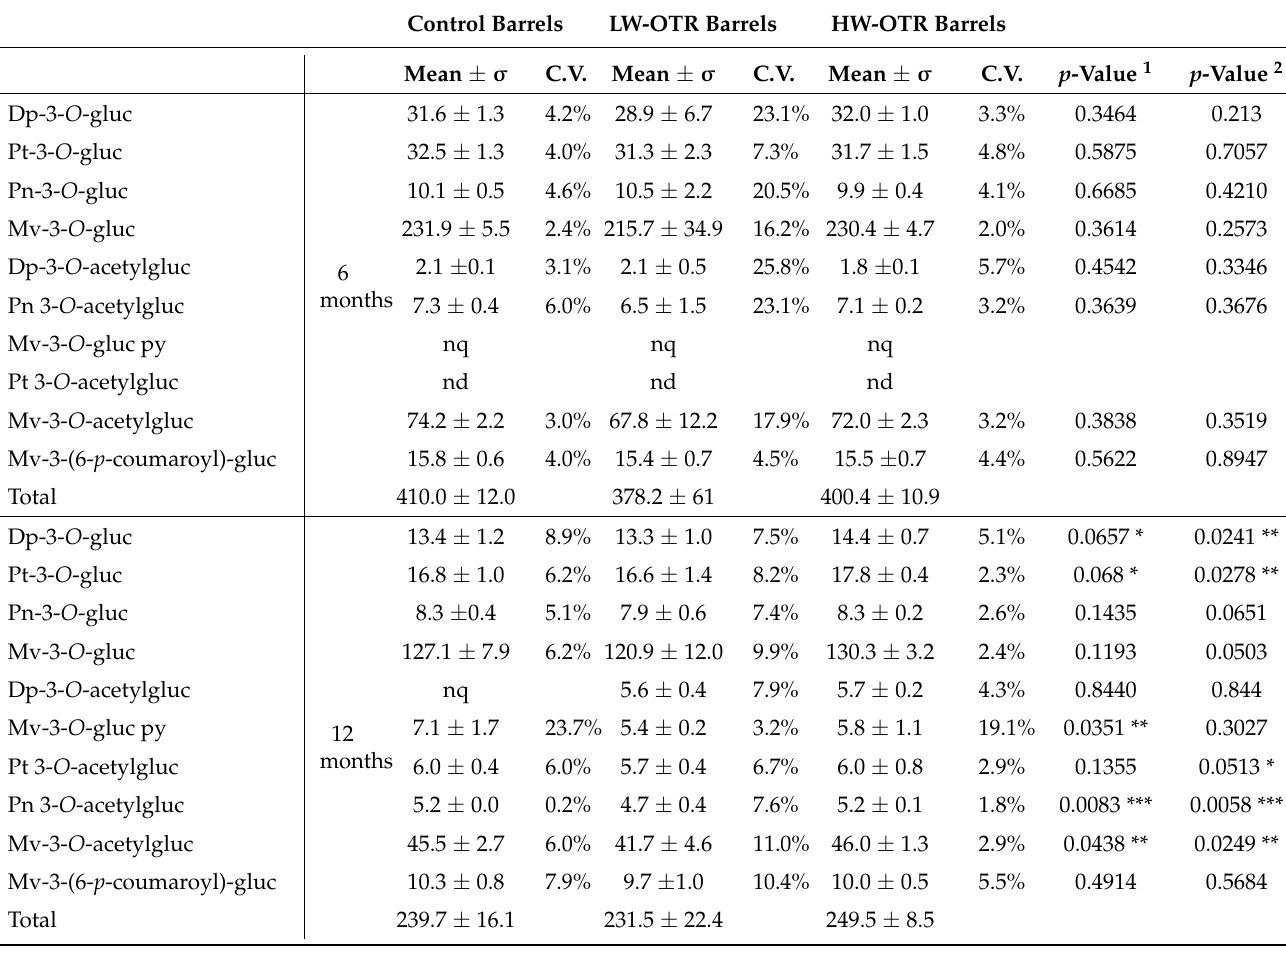
Table 2. Anthocyanins concentration (mg/L in equivalents of malvidin-3- O -glucoside) determined by HPLC/DAD of the red wines at 6 and 12 months ageing at custom